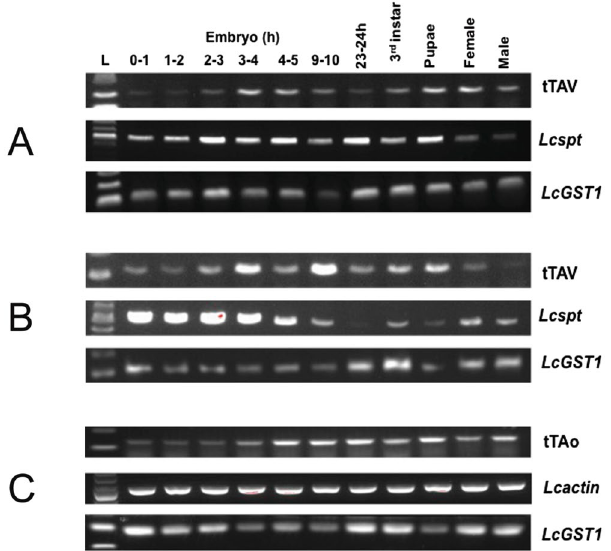
Figure 3. tTA expression at different developmental stages in transgenic driver lines. RNA was isolated from the lines DR3#2, DR3#4 and DR5#4 and analyzed by RT-PCR. The sizes of RT-PCR products are: 206bp for tTAv , 165bp for tTAo , 515bp for Lcspt , 495bp for Lcact5C and 121 bp for LcGST1